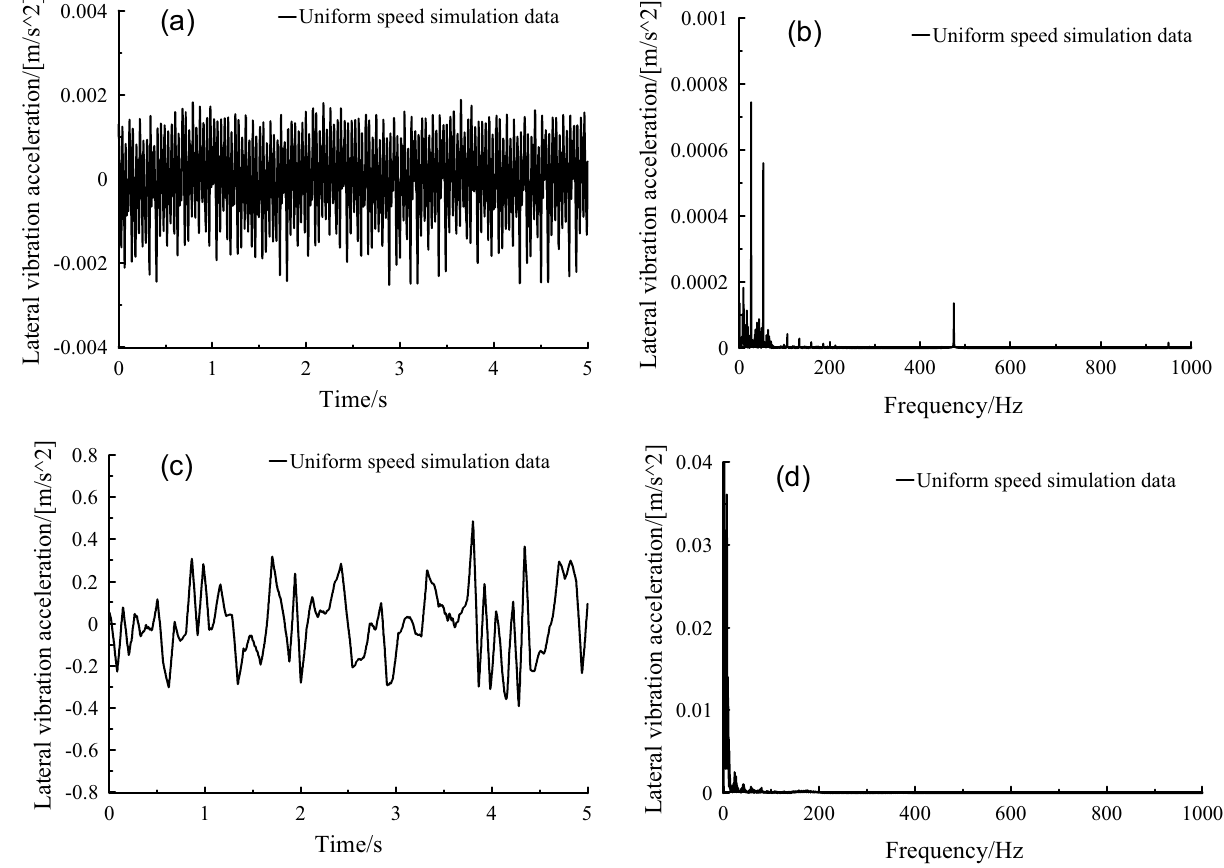
Figure 7. Axle box lateral vibration acceleration, (a-b) orbit free spectrum, (c-d) orbital